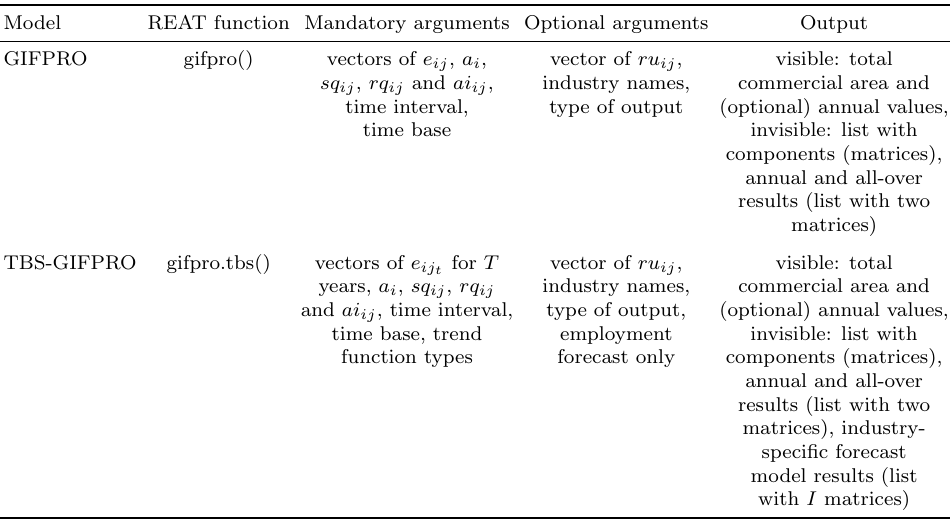
Table 15: REAT functions for commercial area prognosis